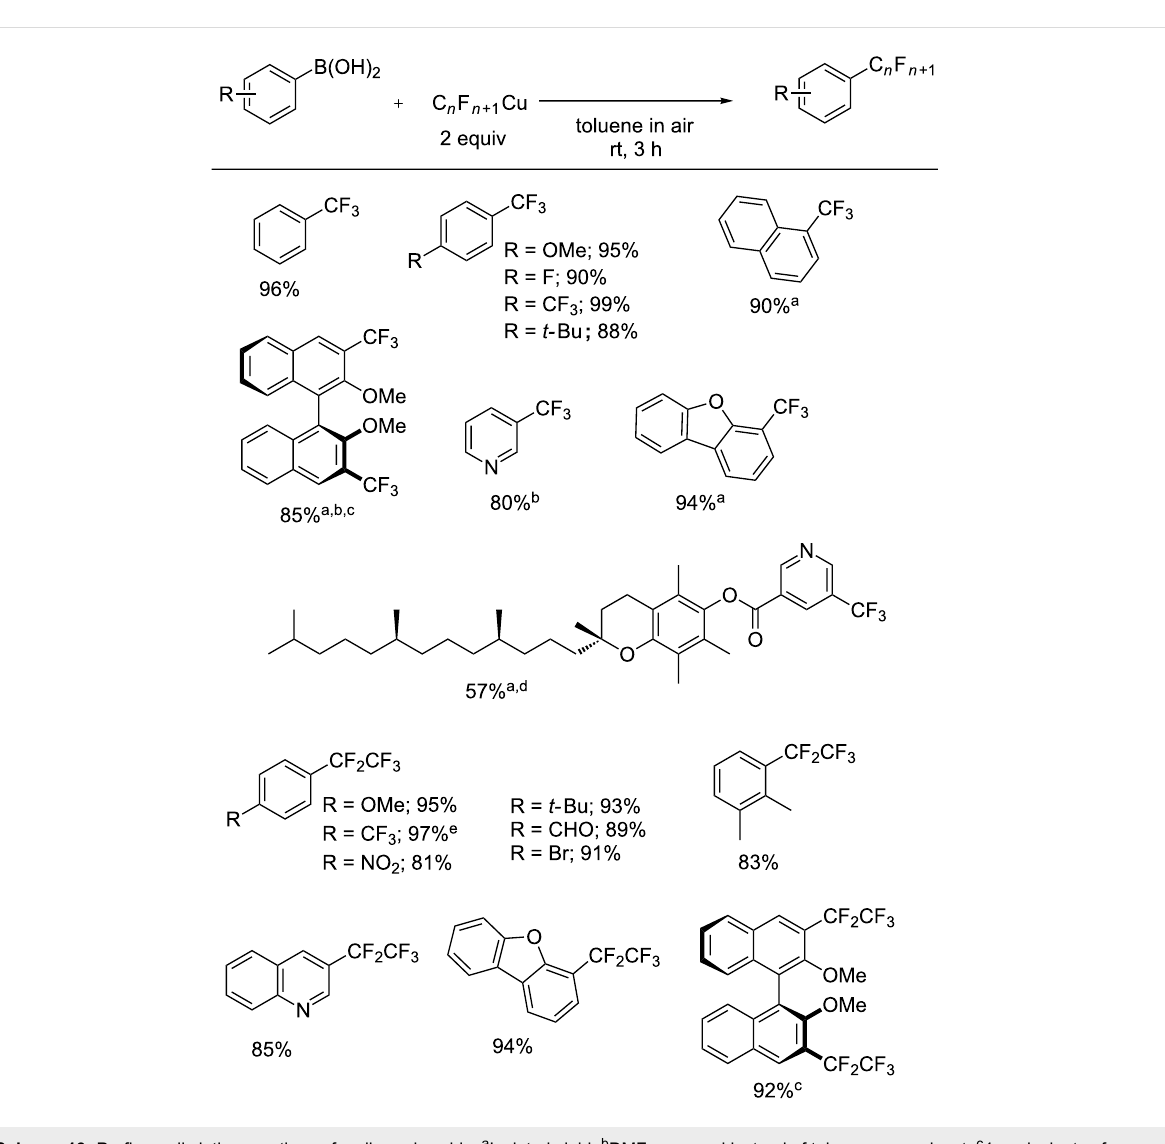
Scheme 13: Perfluoroalkylation reactions of arylboronic acids. a Isolated yield. b DMF was used instead of toluene as a solvent. c 4 equivalents of C